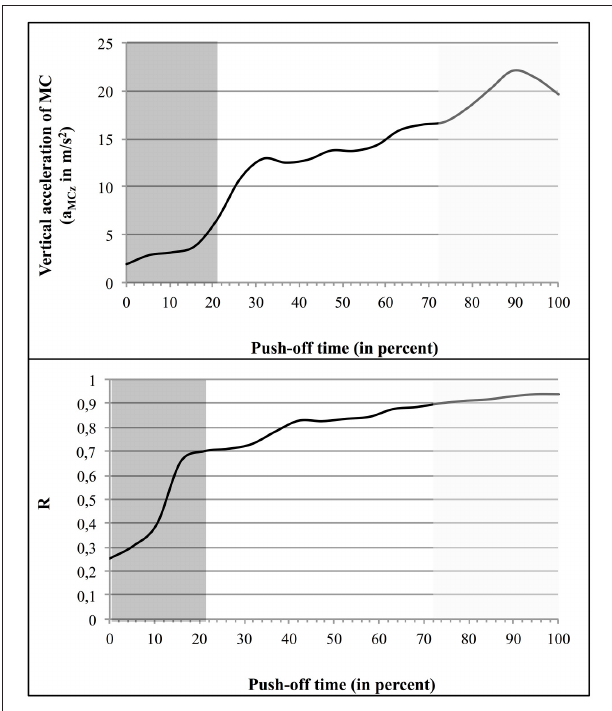
FIGURE 7 | Variation of a CMz and R as function of time: example of the jumper S6. The first coordination type (Ty i ) is indicated by a dark gray background, the second (Ty inter ), by a white background, and the third one (Ty fin ), by a light gray